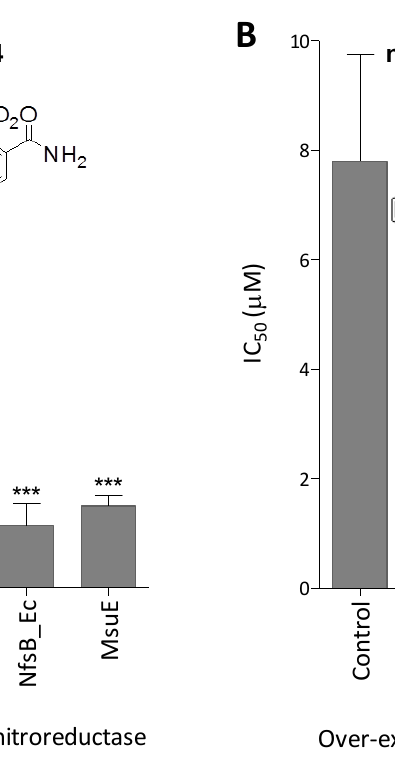
Figure 4. Bacteria-delivered enzyme prodrug cytotoxicity assay. Calculated IC cells post-incubation with E. coli 6KO cells (over-expressing either NfsA_Ec, NfsB_Ec, MsuE, or an empty pUCX control) across a 2-fold dilution series of ( A ) CB1954 (25  M to 400  M); or ( B ) nitro-CBI-DEI (0.06  M to 15  M). Percentage cell survival at each prodrug concentration was calculated relative to an unchallenged control by CellTiter 96 ® AQ One Solution Cell Proliferation Assay (Promega, Madison, WI, USA). Data are the mean of three independent experiments, each performed in duplicate; and error bars are ±1 standard deviation. ** indicates p < 0.005 and *** p < 0.001 by one-way ANOVA with Dunnett comparison of test to